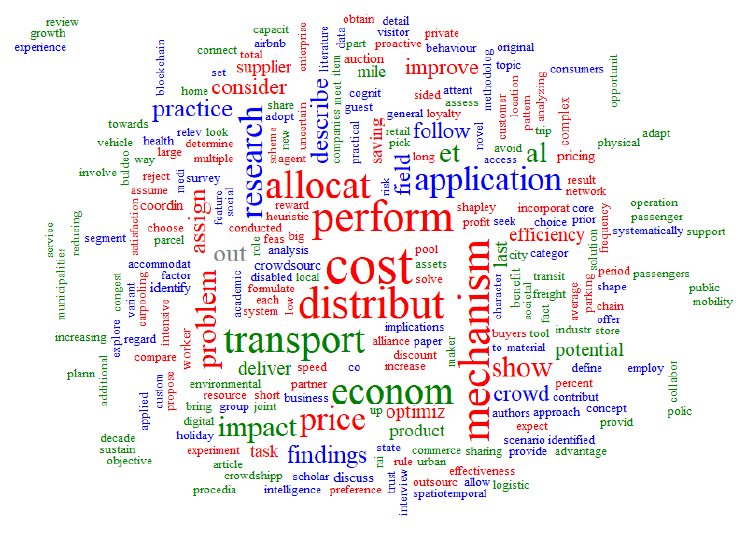
Figure 2. Word cloud and frequency of representative